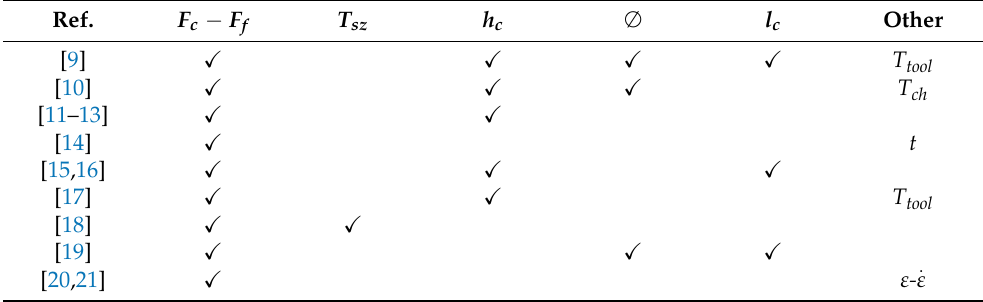
Table 2. Variables employed for the inverse simulation in machining: F c , F f —cutting and feed